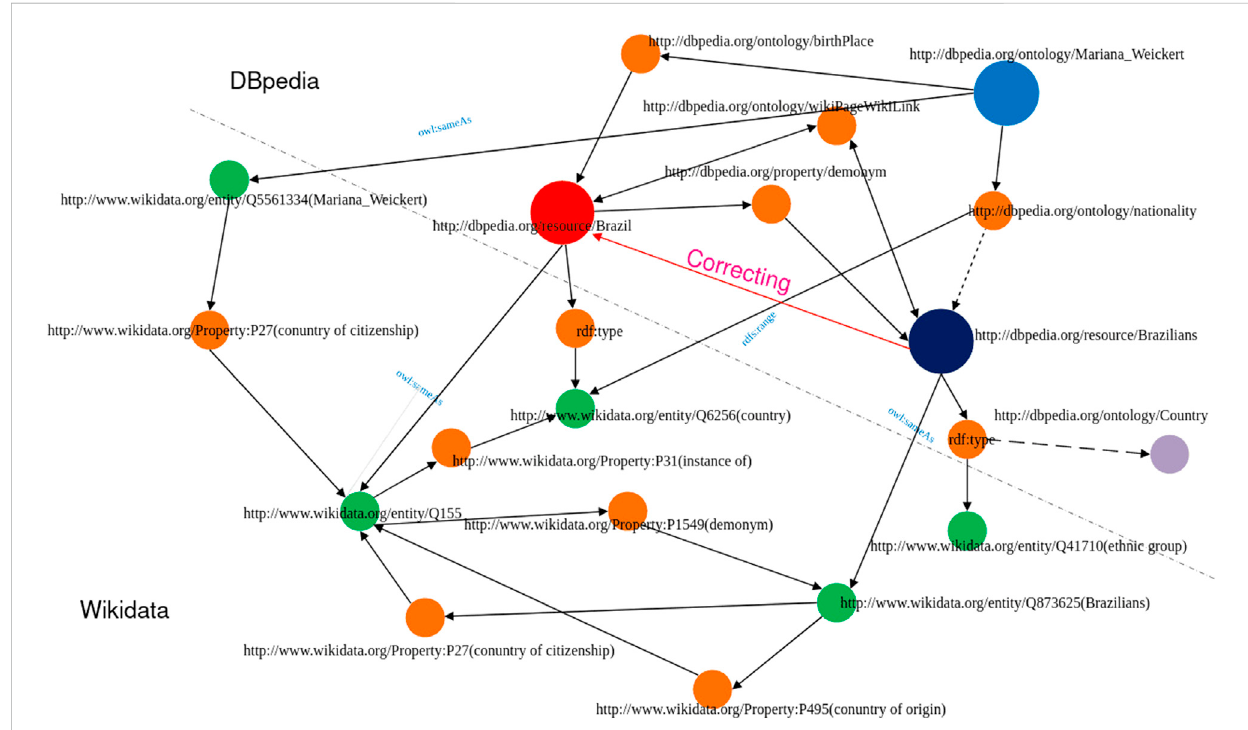
FIGURE 4 EvidencegraphasdisplayedintheTCA(thedarkdotdenoteserroneousentityandtheredoneiscorrected.Orangedotsdenotepredicateproperty, and other colors show the entities between DBpedia and